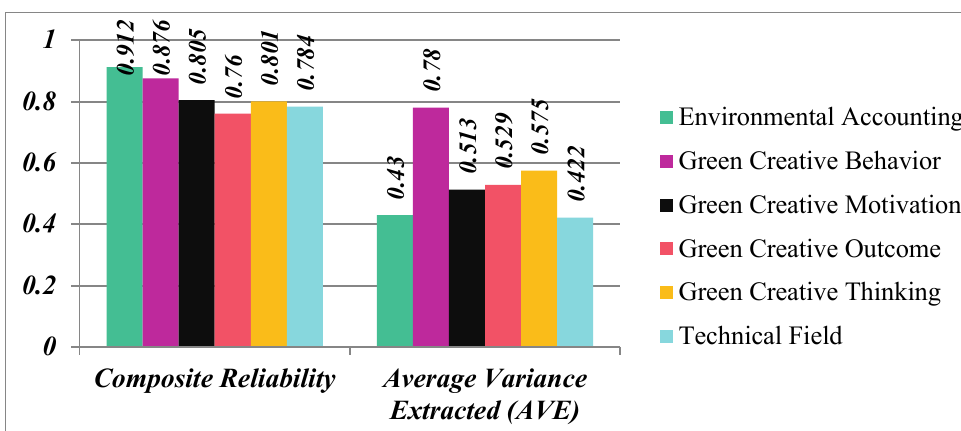
Fig. 1. Measurement model assessment.